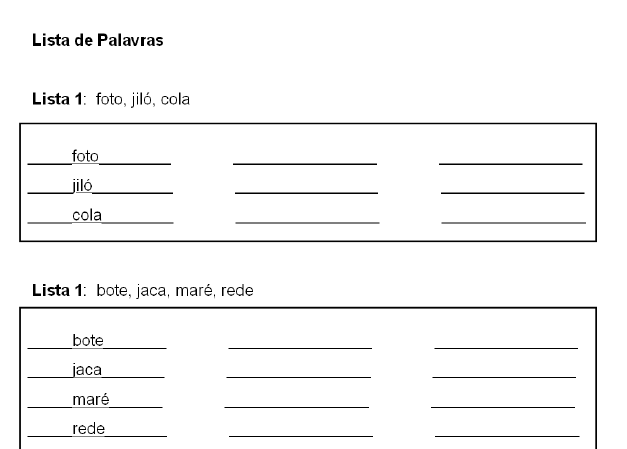
Figura 2 . Exemplo dos itens de velocidade de processamento na modalidade verbal da BAMT-UFMG